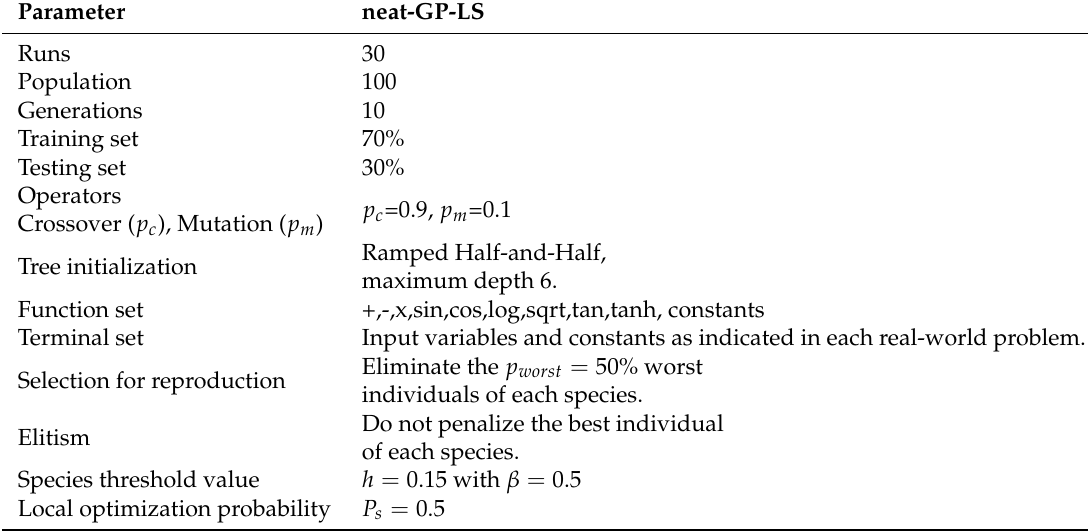
Table 2. Parameters used in real world